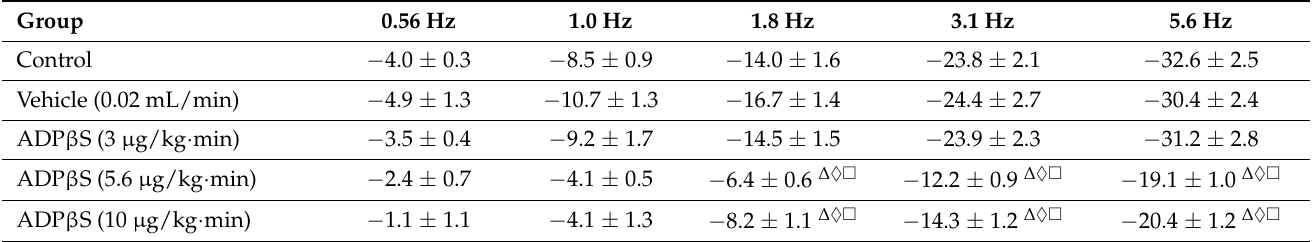
in diastolic blood pressure. Solid symbols indicate a significant difference ( p < 0.05) against the cor ‐ ○ ). Values are indicated as means ± SEM (n = 6 for each subgroup). responding control response ( Table 2. Percentage of the inhibition produced by the infusions (after 10 min) of vehicle (bidistilled water; 0.02 mL/min) or ADP β S (3, 5.6 and 10 μ g/kg ∙ min) on the vasodepressor CGRPergic responses (peak changes) by electrical sensory stimulation in pithed rats.